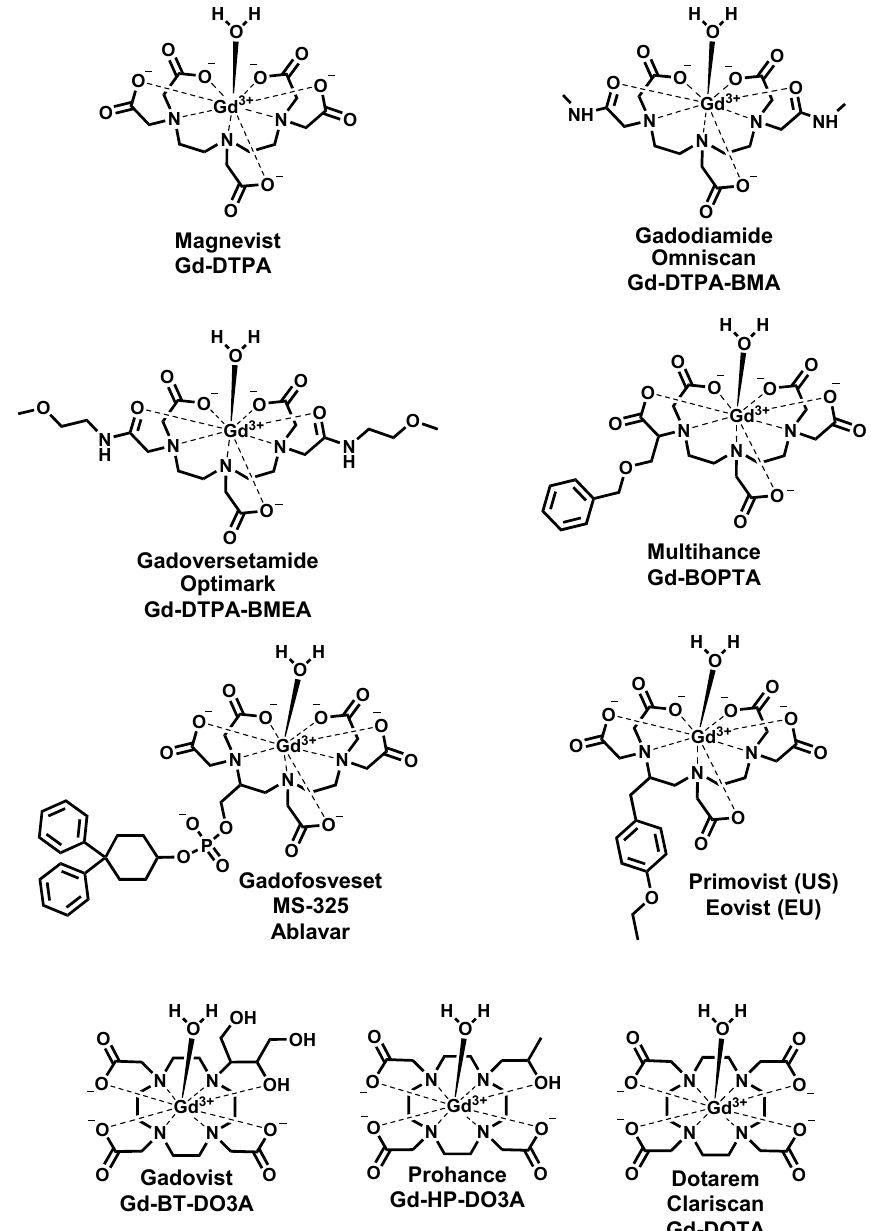
Figure 2. FDA-approved GBCAs utilized in the clinical practice.